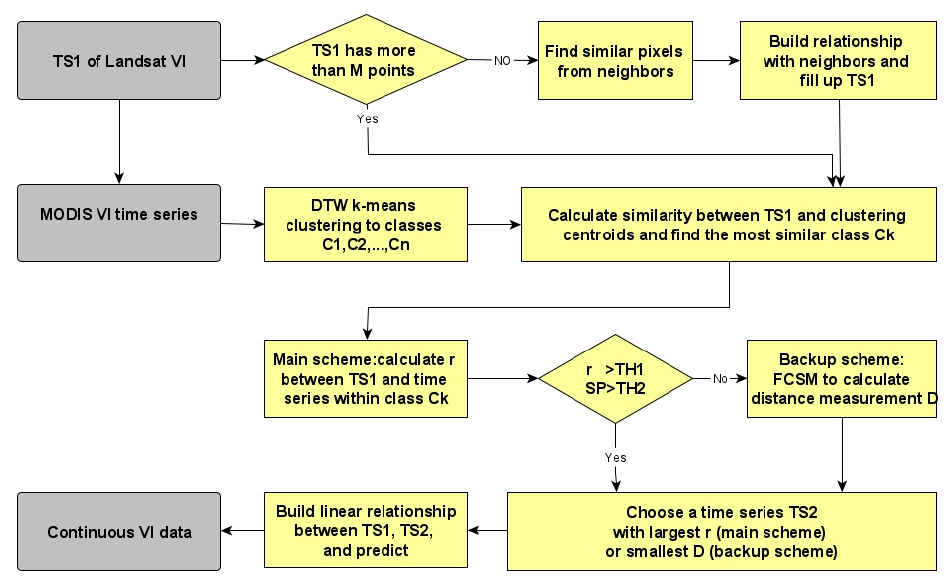
Figure 1. The flowchart of the similarity matching (SIM) process.